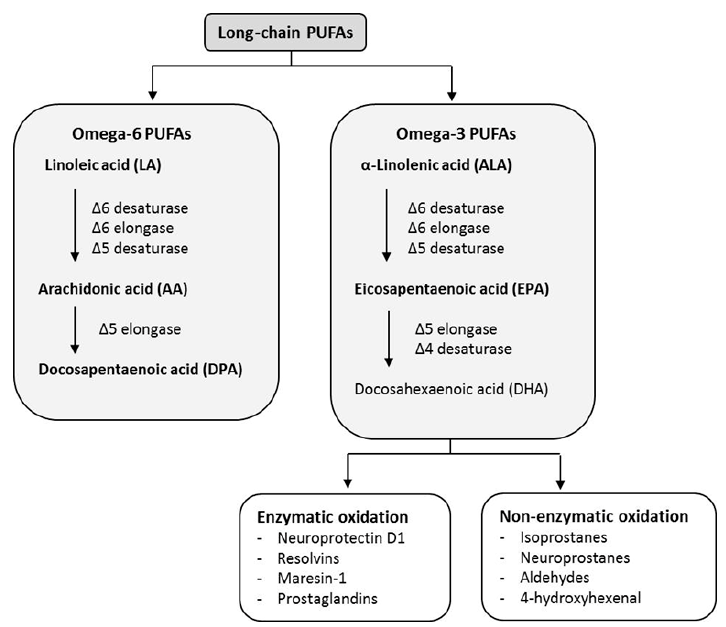
Figure 2. Polyunsaturated fatty acids (PUFAs) subclasses: omega-6 and omega-3.